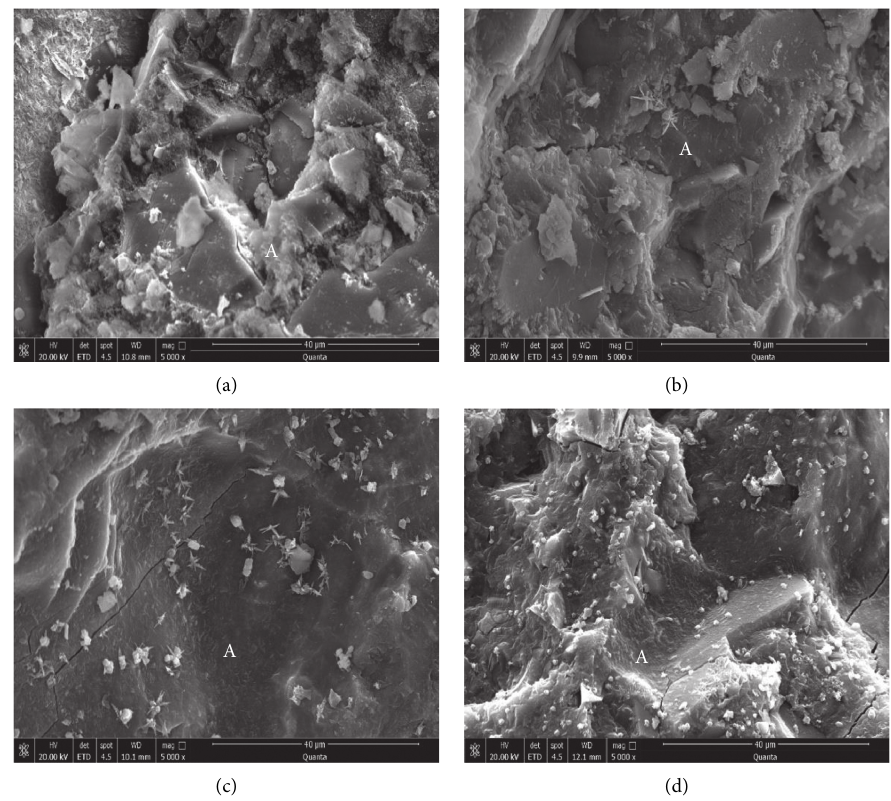
Figure 8: SEM images of NH8.52 (magnification: 5000x) at one day (a); three days (b); seven days (c); 28 days